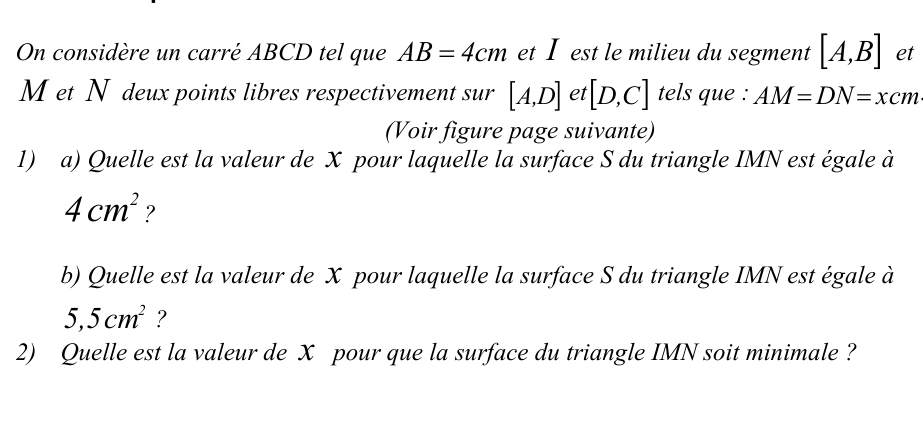
Fig. 4. Présentation avec GeoGebra du cercle trigonométrique (abscisses curvilignes).